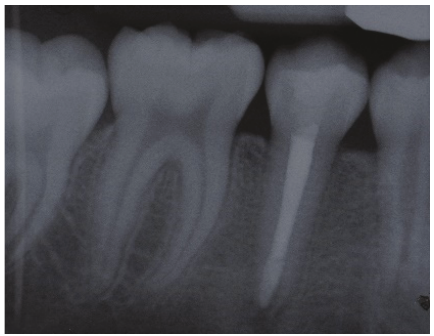
Figure 4: Periapical radiograph of tooth 45 after root canal obturation with thermoplasticised